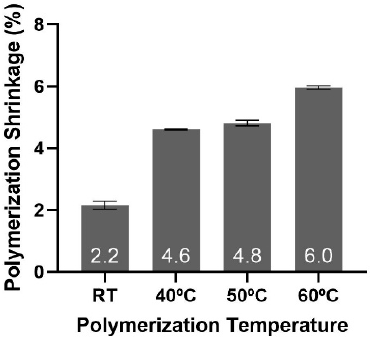
Figure 7. Polymerization shrinkage as a function of initial polymerization temperature. Data are presented as mean with SD.